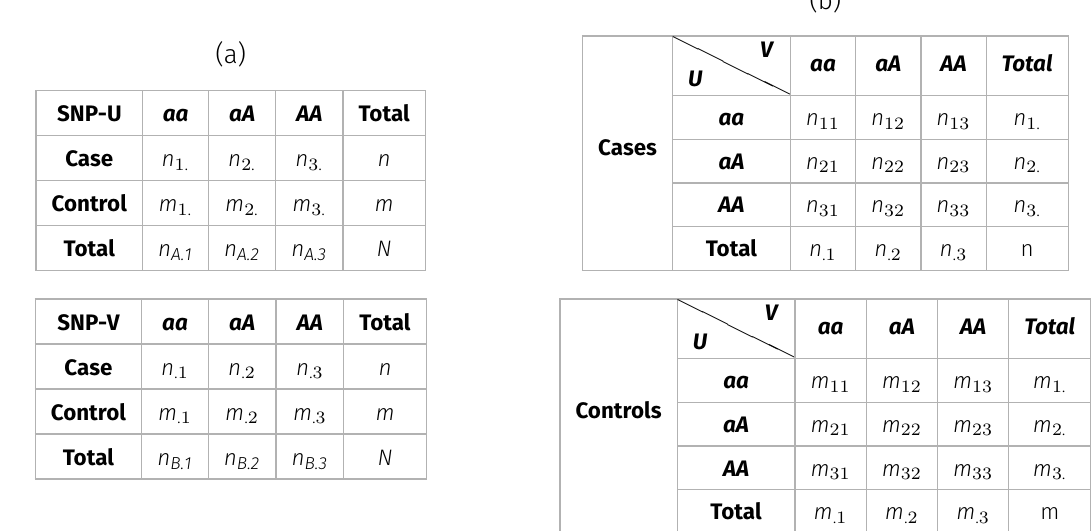
Table I. (a) Contingency tables of SNP-U and SNP-V (b) Contingency tables for interaction of two SNPs for cases and